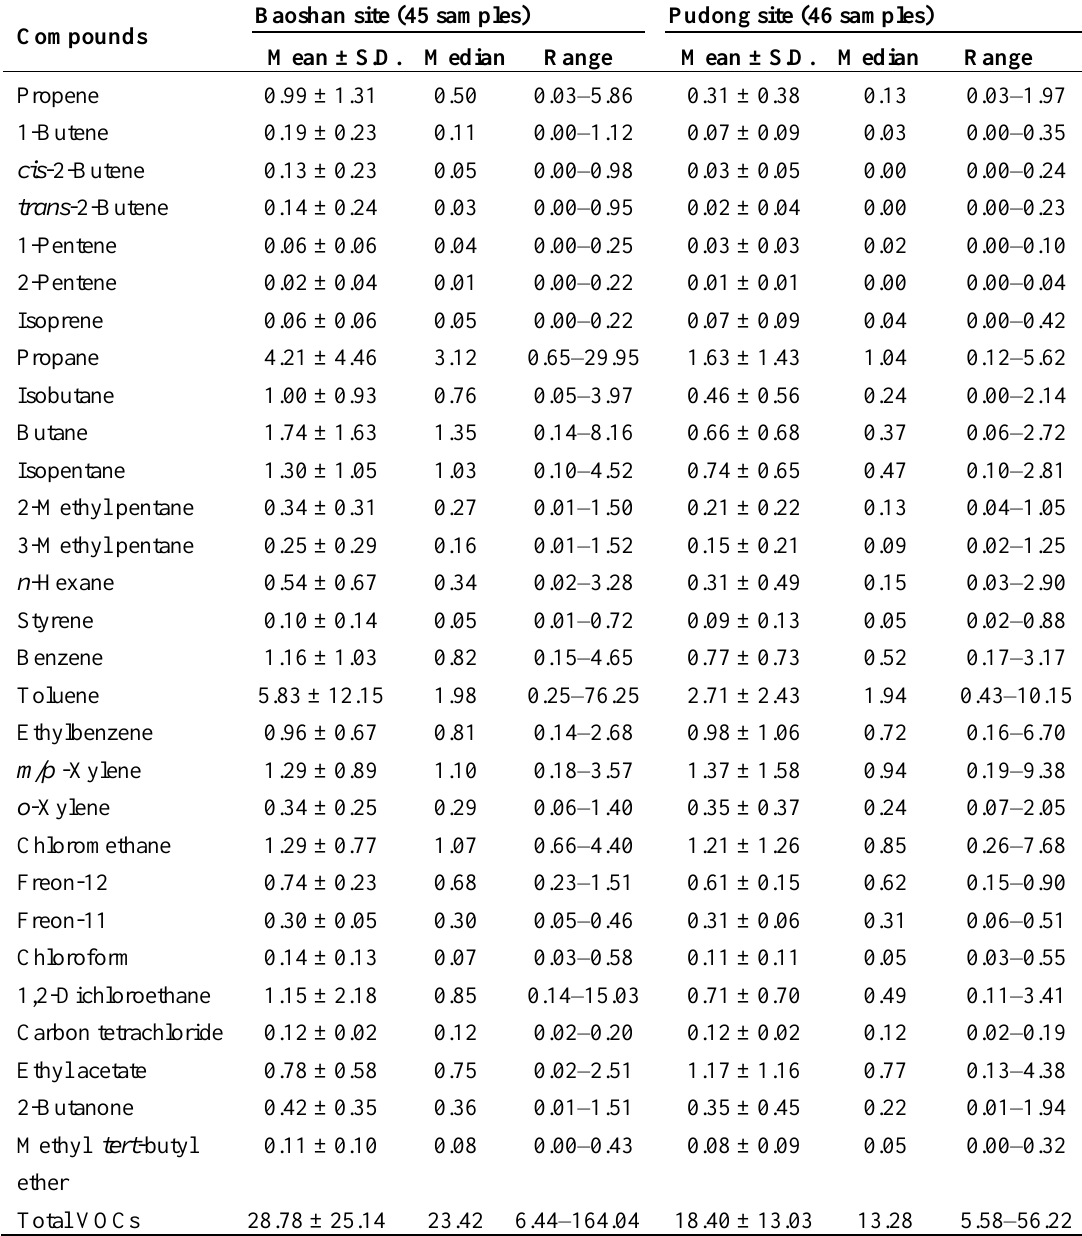
Table 3. Measured VOC concentrations (ppbv) at Baoshan and Pudong sampling sites (sampling period: 8 samples per day with a 3 hour